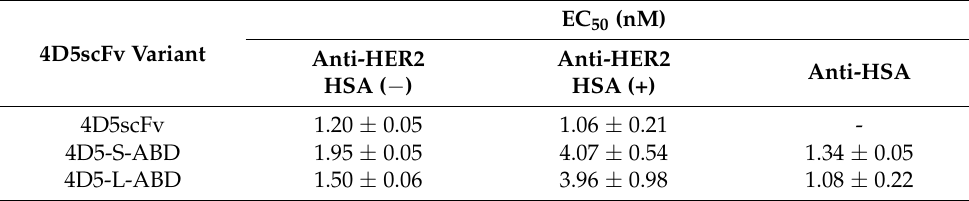
Figure 4. ( a ) Anti-HER2 ELISA of 4D5scFv and two 4D5-ABD variants, in the absence or presence of HSA. ( b ) Anti-HSA ELISA of two 4D5-ABD variants. Table 1. EC 50 value of 4D5scFv and two 4D5-ABD variants measured in the anti-HER2 ELISA and anti-HSA ELISA.